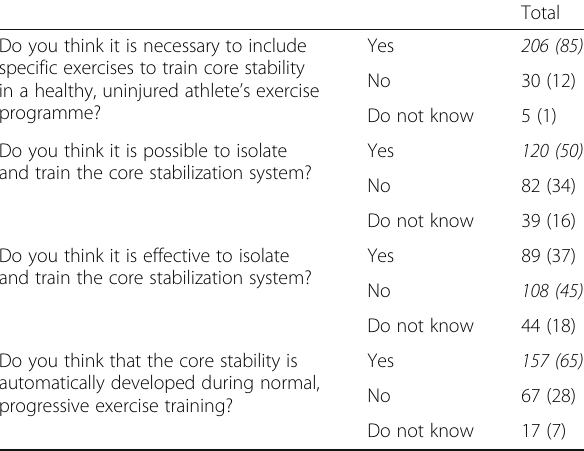
Table 3 Answer to a series of questions about the